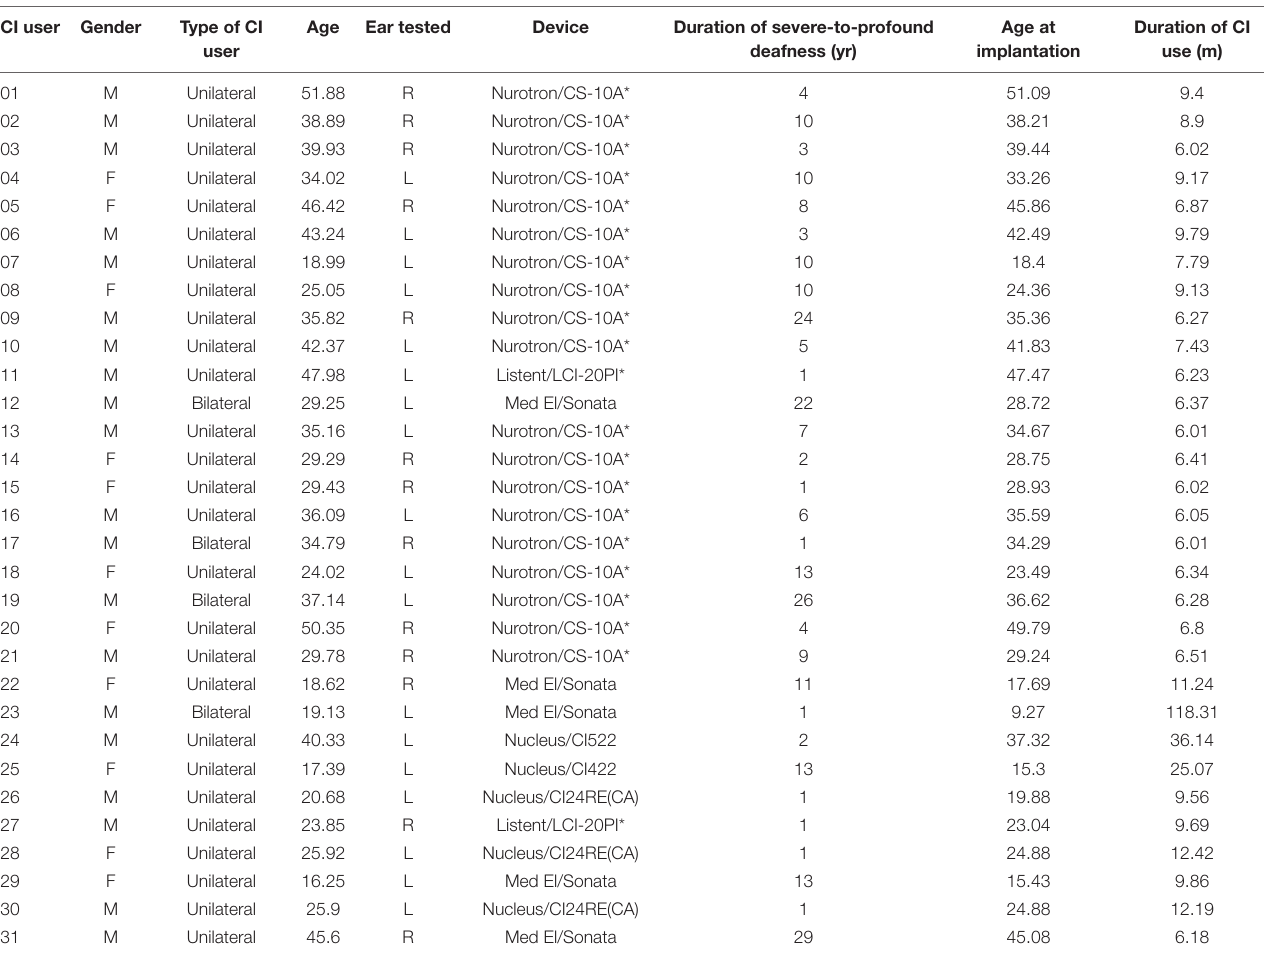
TABLE 1 | Cochlear implant (CI) users’